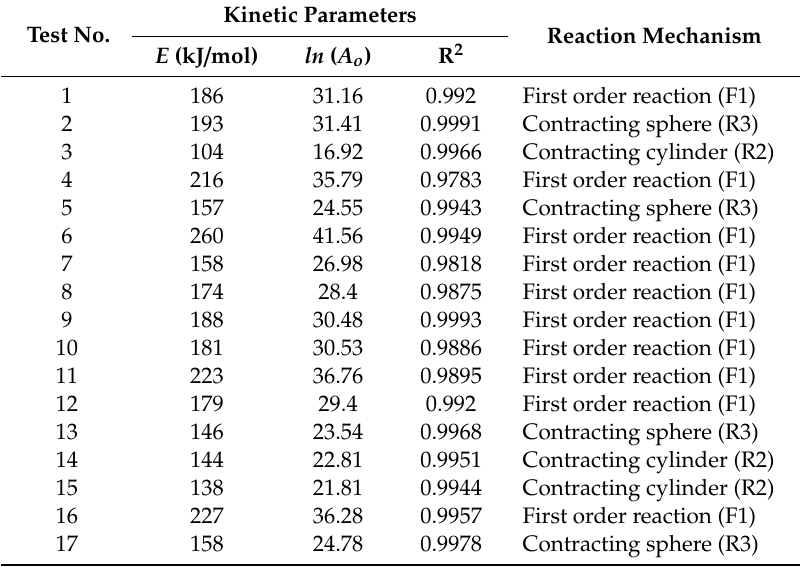
Table 6. Kinetic parameters of the pyrolysis of mixed polymers obtained by the Coats–Redfern model. Test